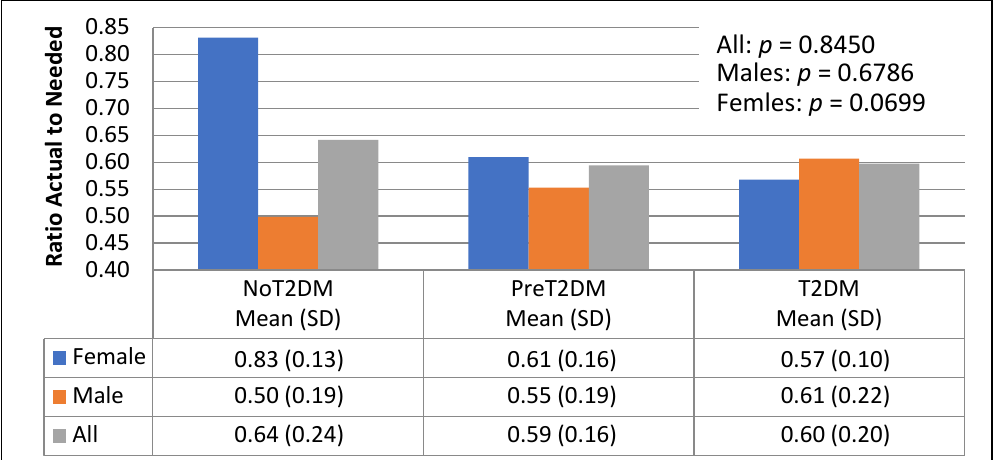
Figure 7. Actual to needed kilocalories from protein by diabetes status and gender.